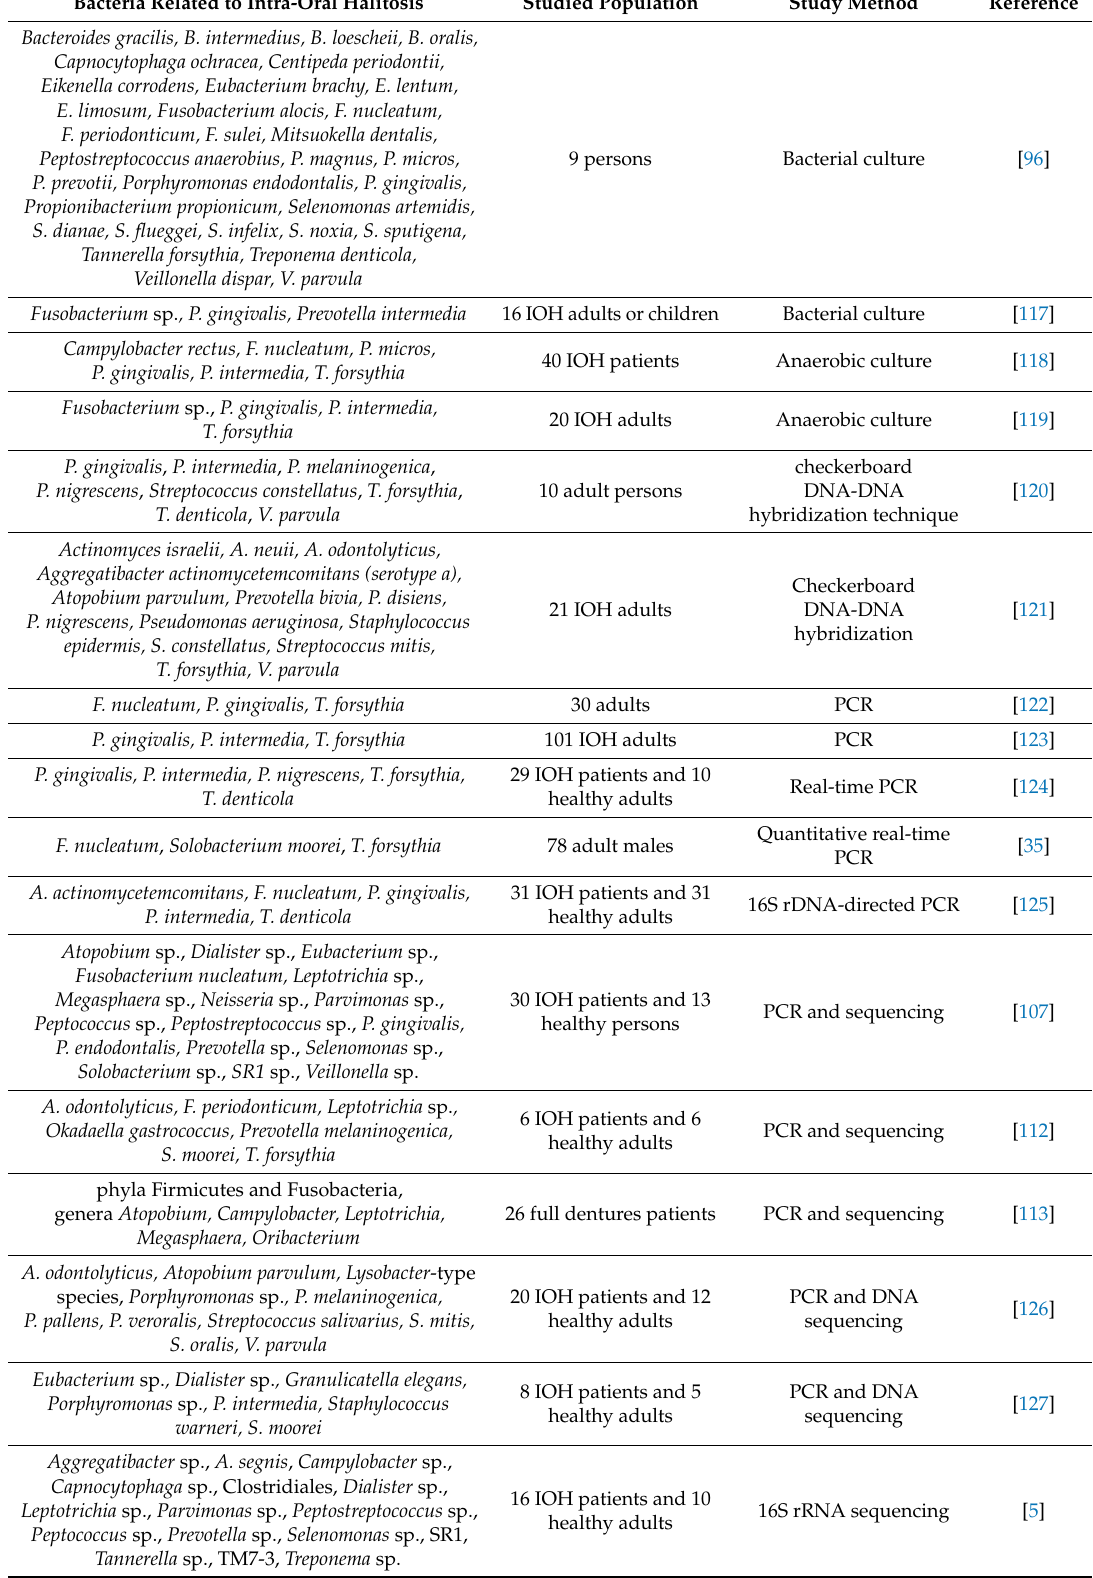
Table 3. Results of studies concerning bacteria associated with intra-oral halitosis (IOH). Bacteria Related to Intra-Oral